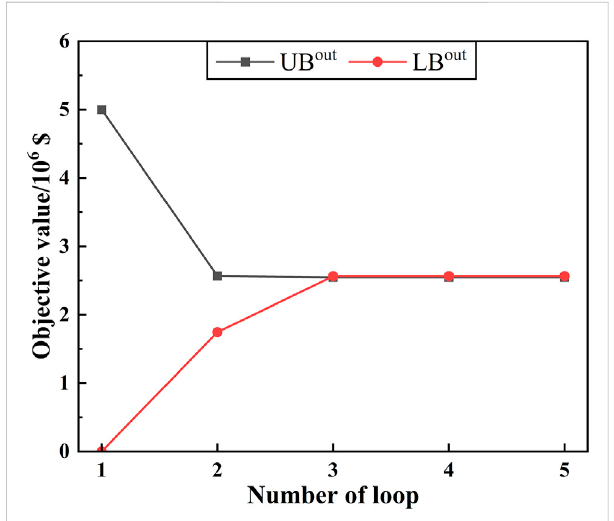
Table 7. Case 1 is the planning framework proposed in this paper, and Case 2 is the control group.